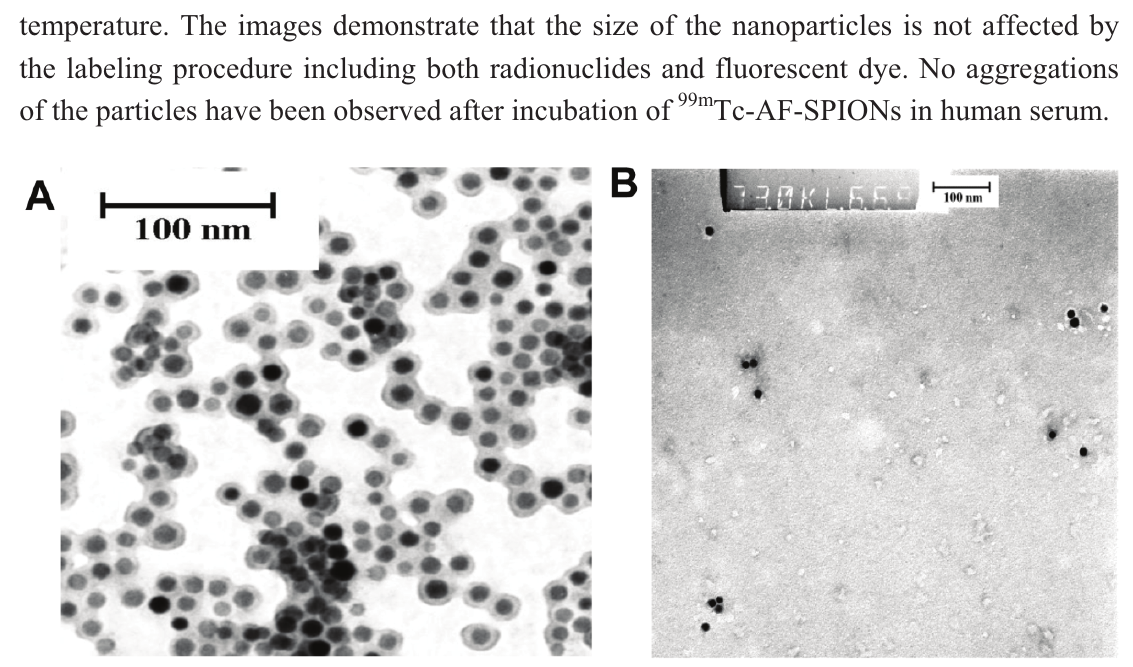
Figure 1. Transmission electron microscopy images of nanoparticles. ( a ) SPIONs in 0.9% saline buffer, pH 7 and ( b ) 99m Tc-AF-SPIONs after incubation in human serum at room